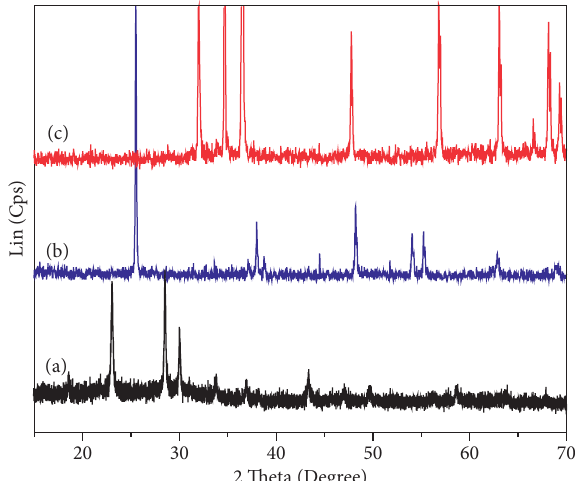
Figure 4: XRD patterns of Ni-X catalysts: (a) Ni-VPO; (b) Ni-TiO